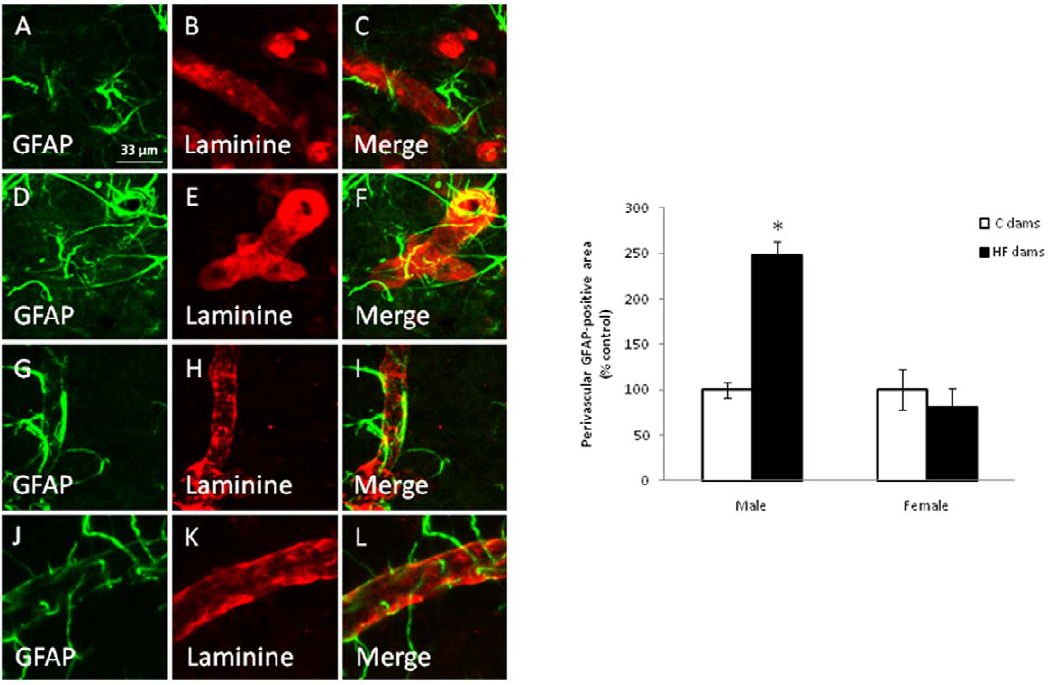
Figure 10. Co-detection of a glial marker (GFAP) and an endothelial marker (laminin) in male (A–F) and female (G–L) offspring born to dams fed a control (A–C ; G–I) or a high-fat (D–F ; J–L) diet in the arcuate nucleus (ARC) at weaning. Maternal HF diet significantly increases the density of astrocytic processes around the blood vessels in males (p , 0.05) but not in females (D–F, M). Scale bars=33 m m.